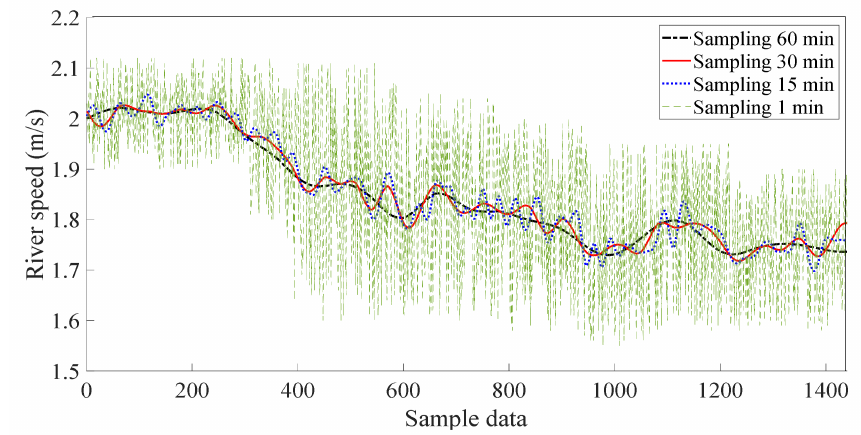
Figure 5. River speed—values measured at different sampling intervals.